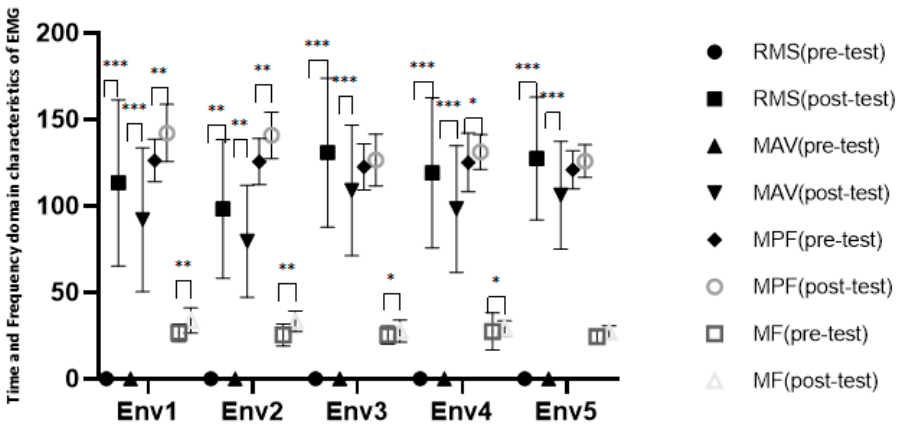
Figure 16. Time and frequency domain characteristics of EMG. Interpretation: * p < 0.05, ** p < 0.01, and *** p < 0.001. Env1, VR urban environment visual experiencing group; Env2, VR restorative environment visual experiencing group; Env3, VR restorative environment interactive experiencing group; Env4, VR restorative environment with fishing interaction group; Env5, VR restorative environment with watering interaction group.